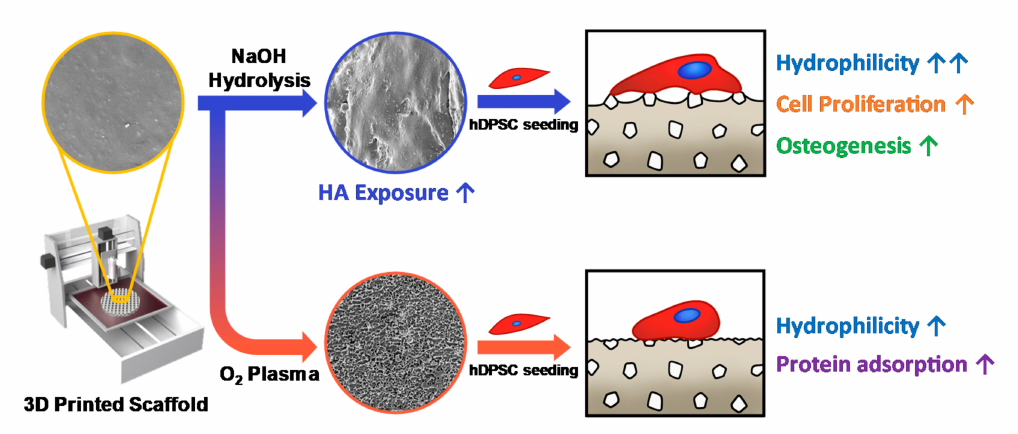
Figure 1. The schematic illustration of this study. We fabricated 3D scaffolds with different characteristics using a 3D printing process and surface modification techniques. NaOH treatment is a suitable method to expose the hydroxyapatite (HA) particles on the surface of the poly( ε -caprolactone) (PCL)/HA scaffold, which promotes proliferation and osteogenesis of human dental pulp-derived stem cells